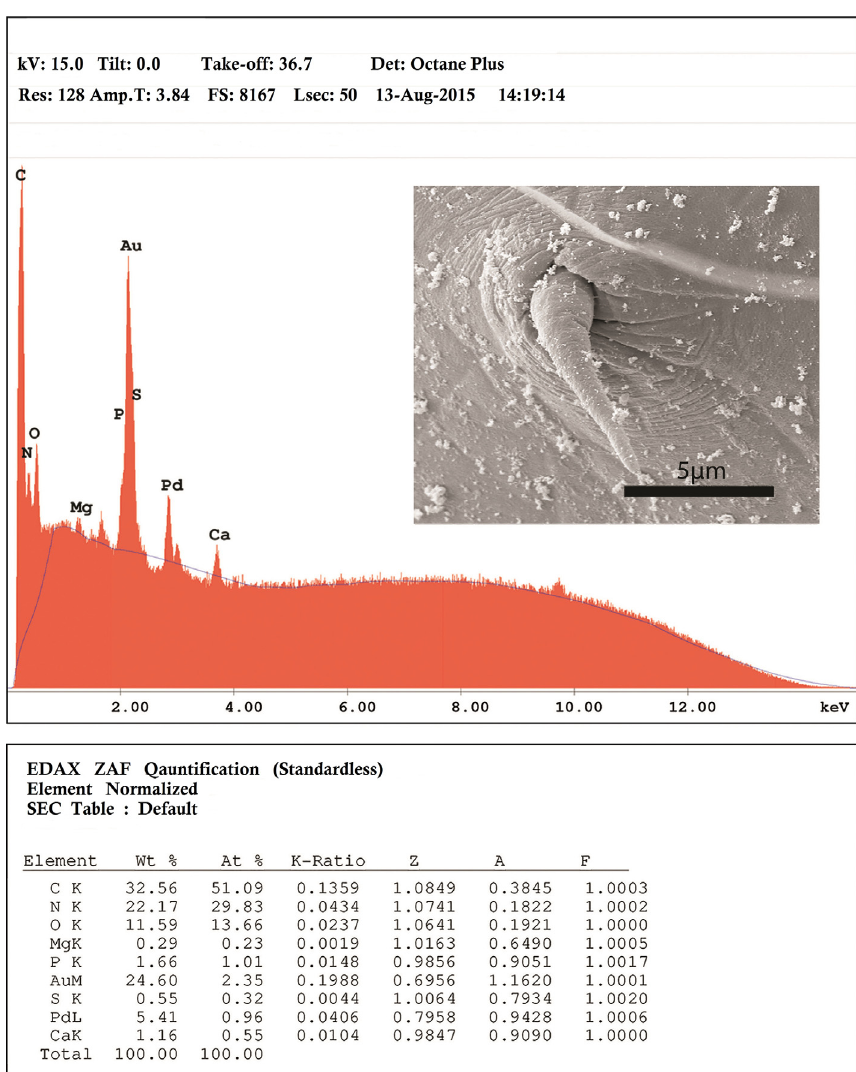
Figure 24. The printout for the elemental scan (EDXA) for the miniature apical hook at the apex of the E. baeri proboscis. Note the drop in calcium and phosphorus peaks compared to that of normal hooks (Fig.